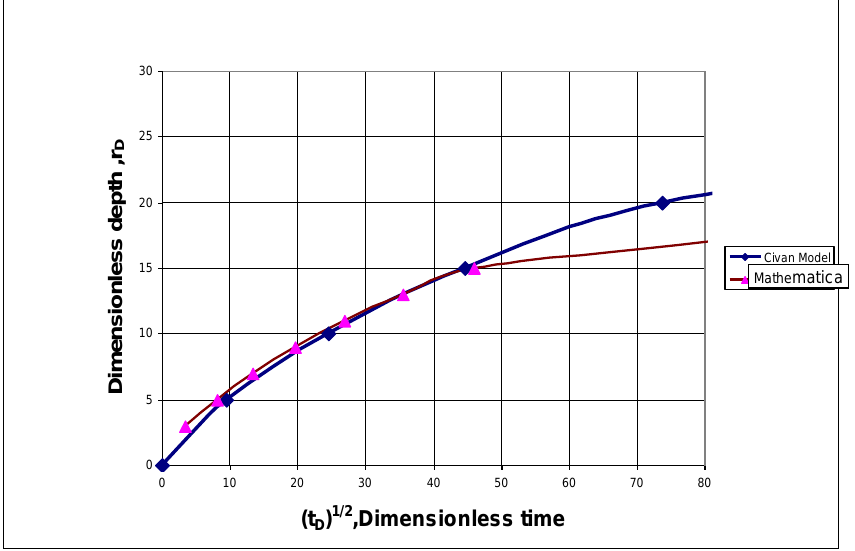
Figure 2 . Comparisons between two analytical solutions by Civan and